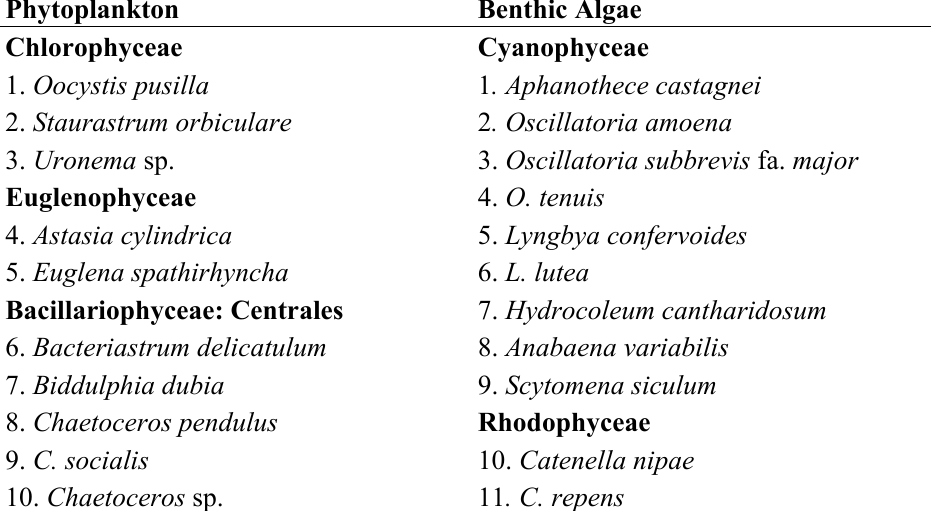
Table 3. Phytoplankton [25] and benthic [33] algal flora of the BSMF. Phytoplankton Benthic